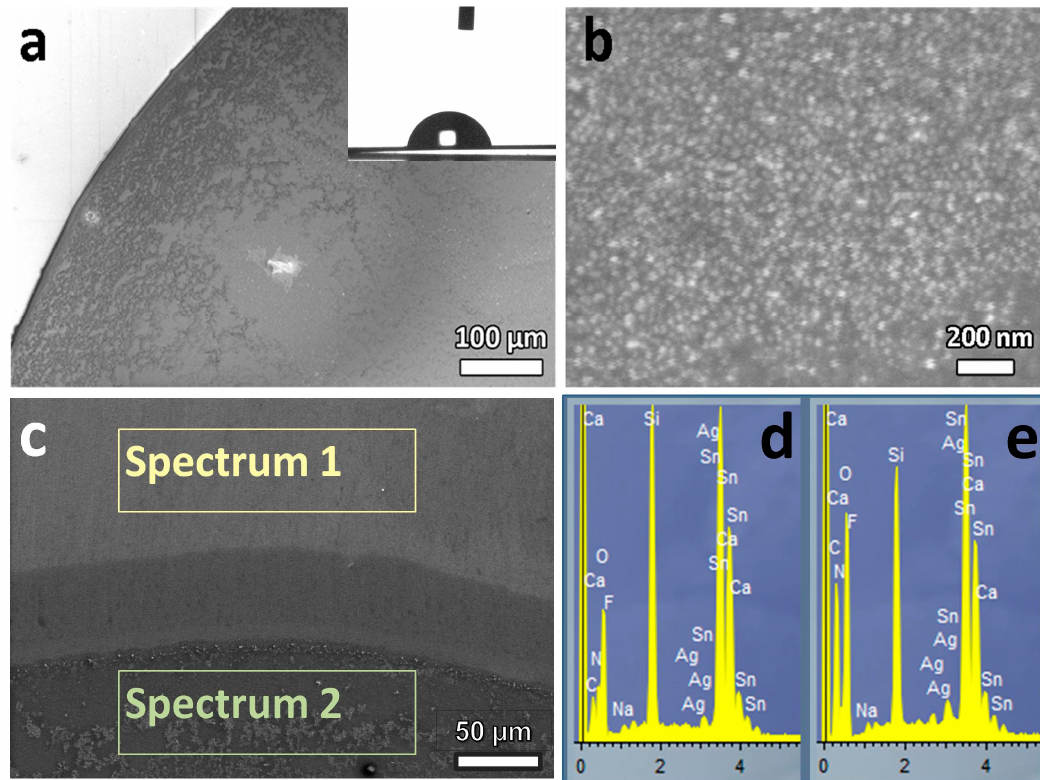
Figure 4. ( a , b ) Scanning electron microscopy (SEM) images of the hierarchical silver structures formed from silver citrate complex ink (H 2 O:EG) after 8 min UV induced reduction on the quartz substrate. ( a ) Inset: Side view of the ink droplet before drying. ( c – e ) Energy dispersive X-ray spectroscopy (EDX) data for the similar droplet deposited onto FTO glass substrate.